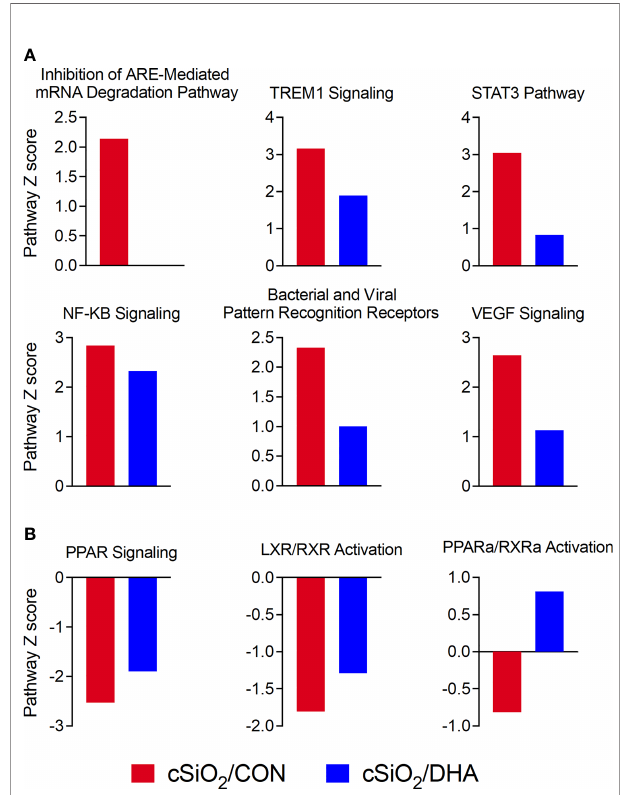
FIGURE 10 | DHA-rich diet suppresses cSiO 2 -triggered immune-related pathways and reverses cSiO 2 -induced suppression of lipid metabolism pathways. Canonical pathway analysis was performed for comparison of in fl ammatory proteins from cSiO 2 /CON (blue bars) and cSiO 2 /DHA groups (red bars) using IPA tools. Signi fi cant (p ≤ 0.05) Z-scores that were greater than 2 (absolute value) for immune-related function (A) and lipid metabolism (B) annotations are shown as bar